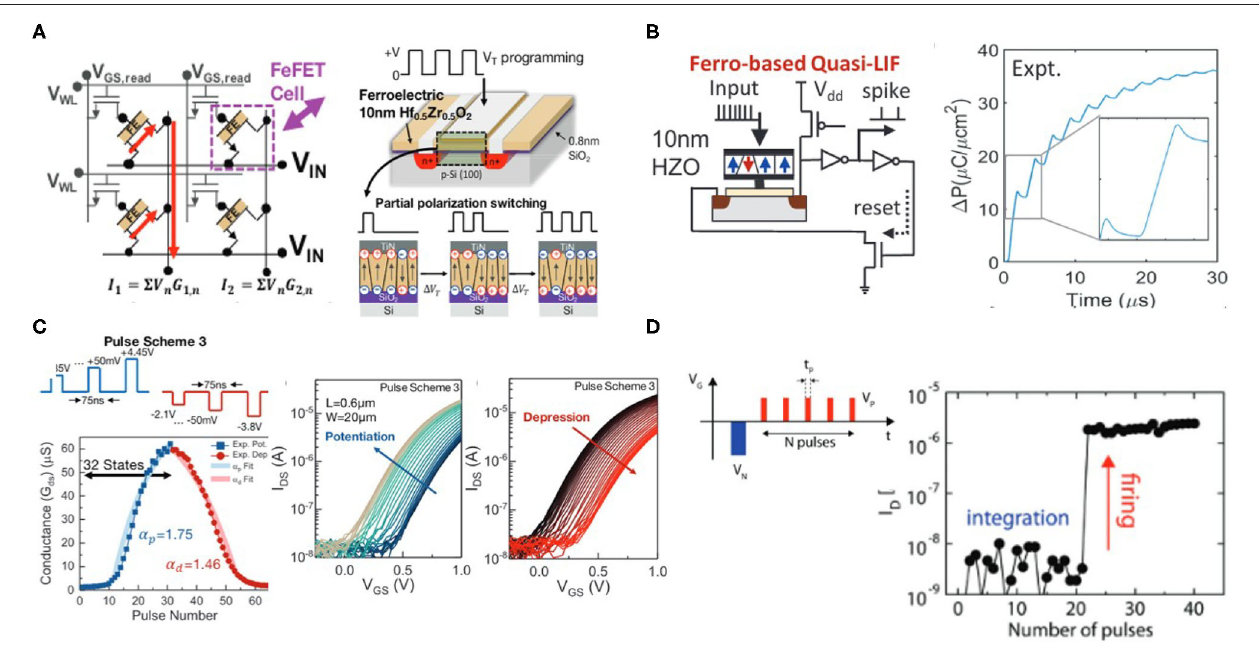
FIGURE 8 | (A) Crossbar implementation of multi-level FeFET cells for neuromorphic computing. Figure reproduced with permission from Jerry et al. (2017) IEEE International Electron Devices Meeting (IEDM), p. 6-2, Copyright 2017 IEEE. (B) Ferroelectric-based device emulating a leaky-integrate-fire (LIF) neuron. Figure reproduced with permission from Dutta et al. (2019) Symposium on VLSI Technology T140-T141 (IEEE) Copyright 2019 IEEE. (C) Voltage pulsing scheme achieving synaptic weight updates in FeFET devices with improved symmetry in conductance change during potentiation and depression processes. Figure reproduced with permission from Jerry et al. In 2017 IEEE International Electron Devices Meeting (IEDM), p. 6-2, Copyright 2017 IEEE. (D) FeFET based IF spiking neuron. The firing of neuron can be observed and sensed from the abrupt change of drain current. Figure adapted from Mulaosmanovic, et al. Nanoscale 10, 21755–21763 (2018) with permission from The Royal Society of Chemistry.